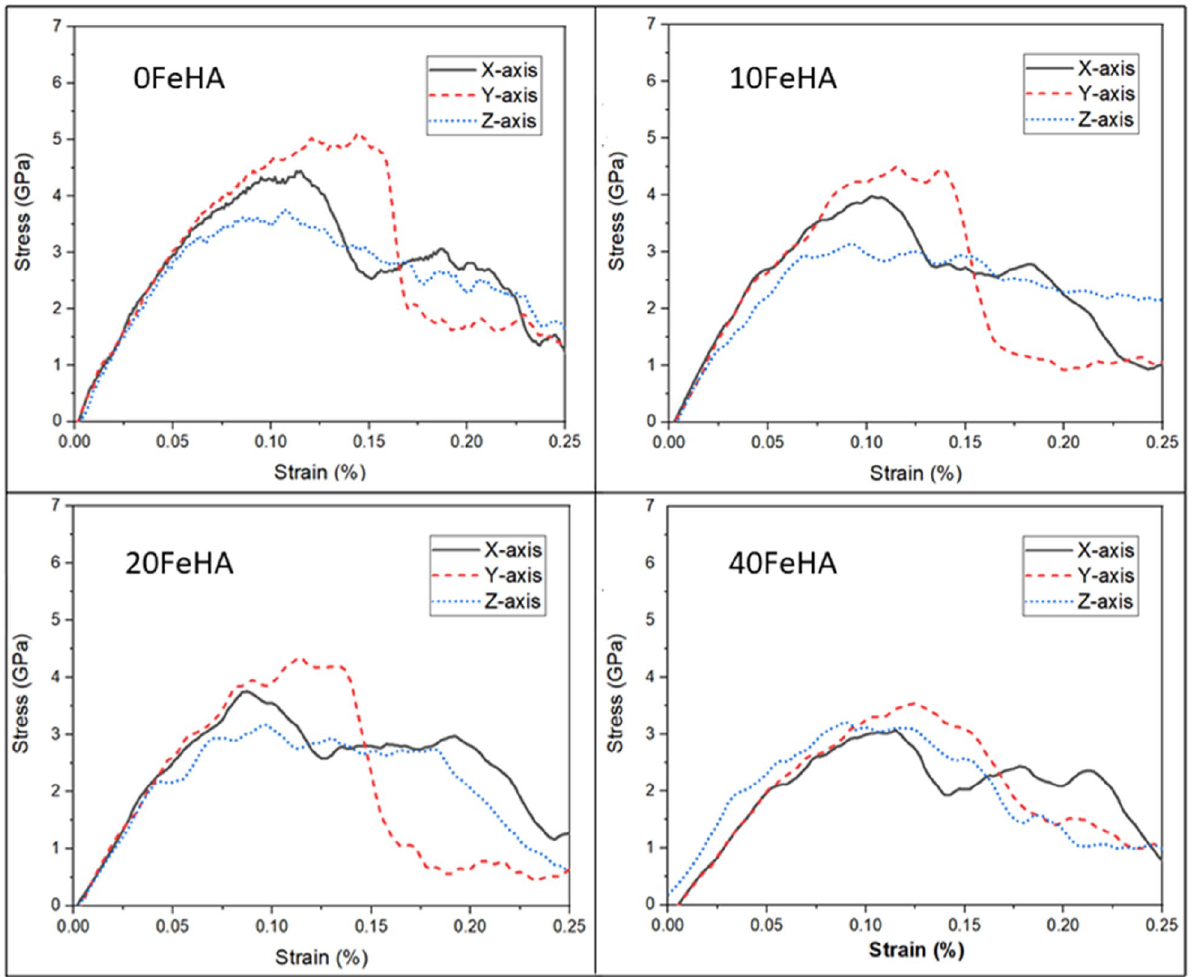
Figure 7. Uniaxial tensile stress–strain at T = 400 K for different doped HA, as analyzed using MD simulation. (Sample designation: xFeHA means x mol% Fe 2+ -doped HA). The tensile loading directions along different crystallographic orientations follows similar manner as shown in Fig.